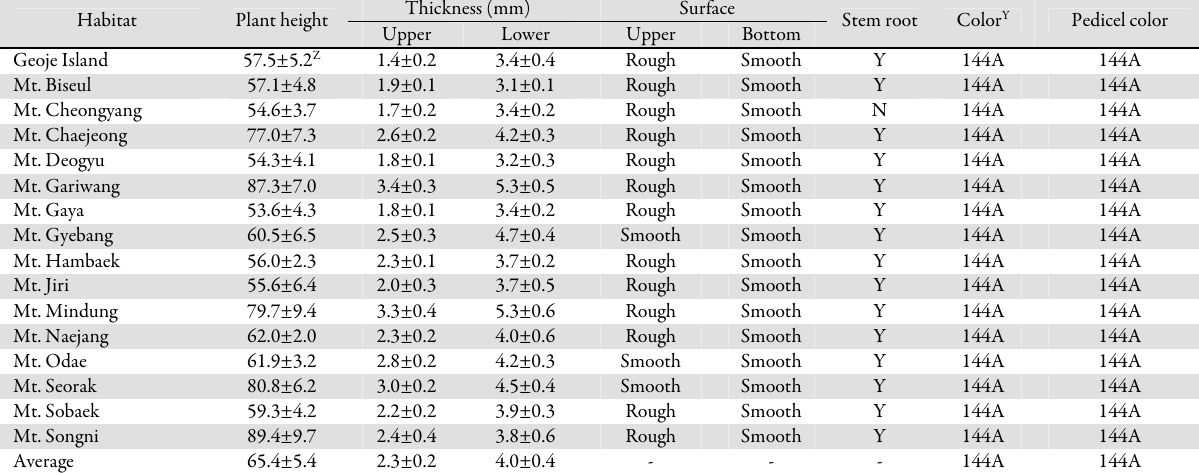
Z Mean ± standard error; Y Stem color indicated by RHS color chart number.